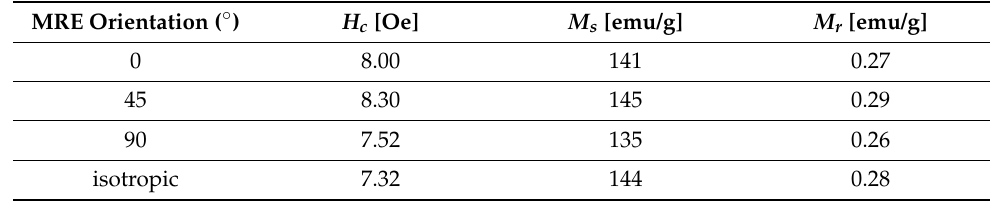
Table 2. Magnetic parameters from the magnetization